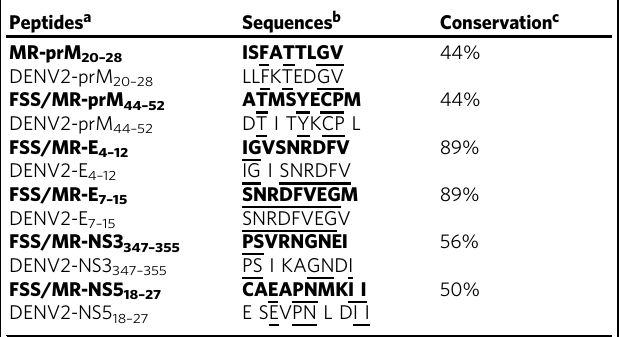
(Table 1). The frequencies of CD3 + CD8 + IFN γ + T cells after ZIKV infection that were restimulated ex vivo with DENV2-E 4 – 12 , DENV2-E 7 – 15 , and DENV2-NS3 347 – 355 were 2.92 ± 0.18%, 0.56 ± 0.1%, and 0.55 ± 0.11%, respectively (two independent experi-